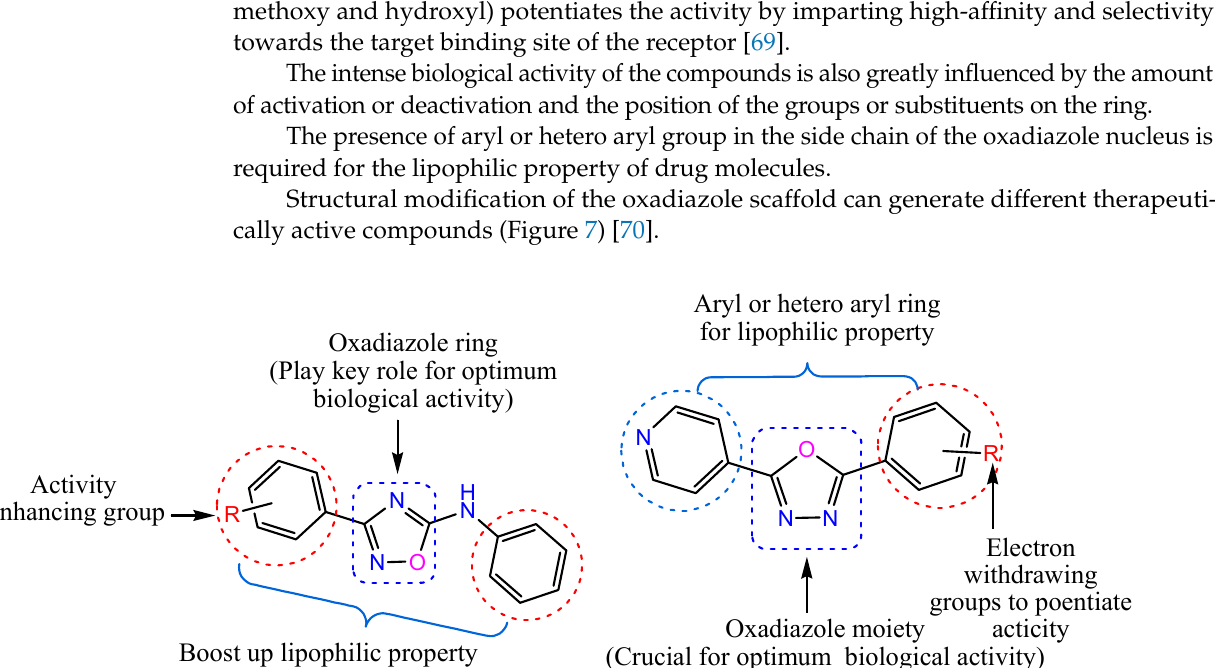
Figure 7. SAR study ofoxadiazole derivatives.